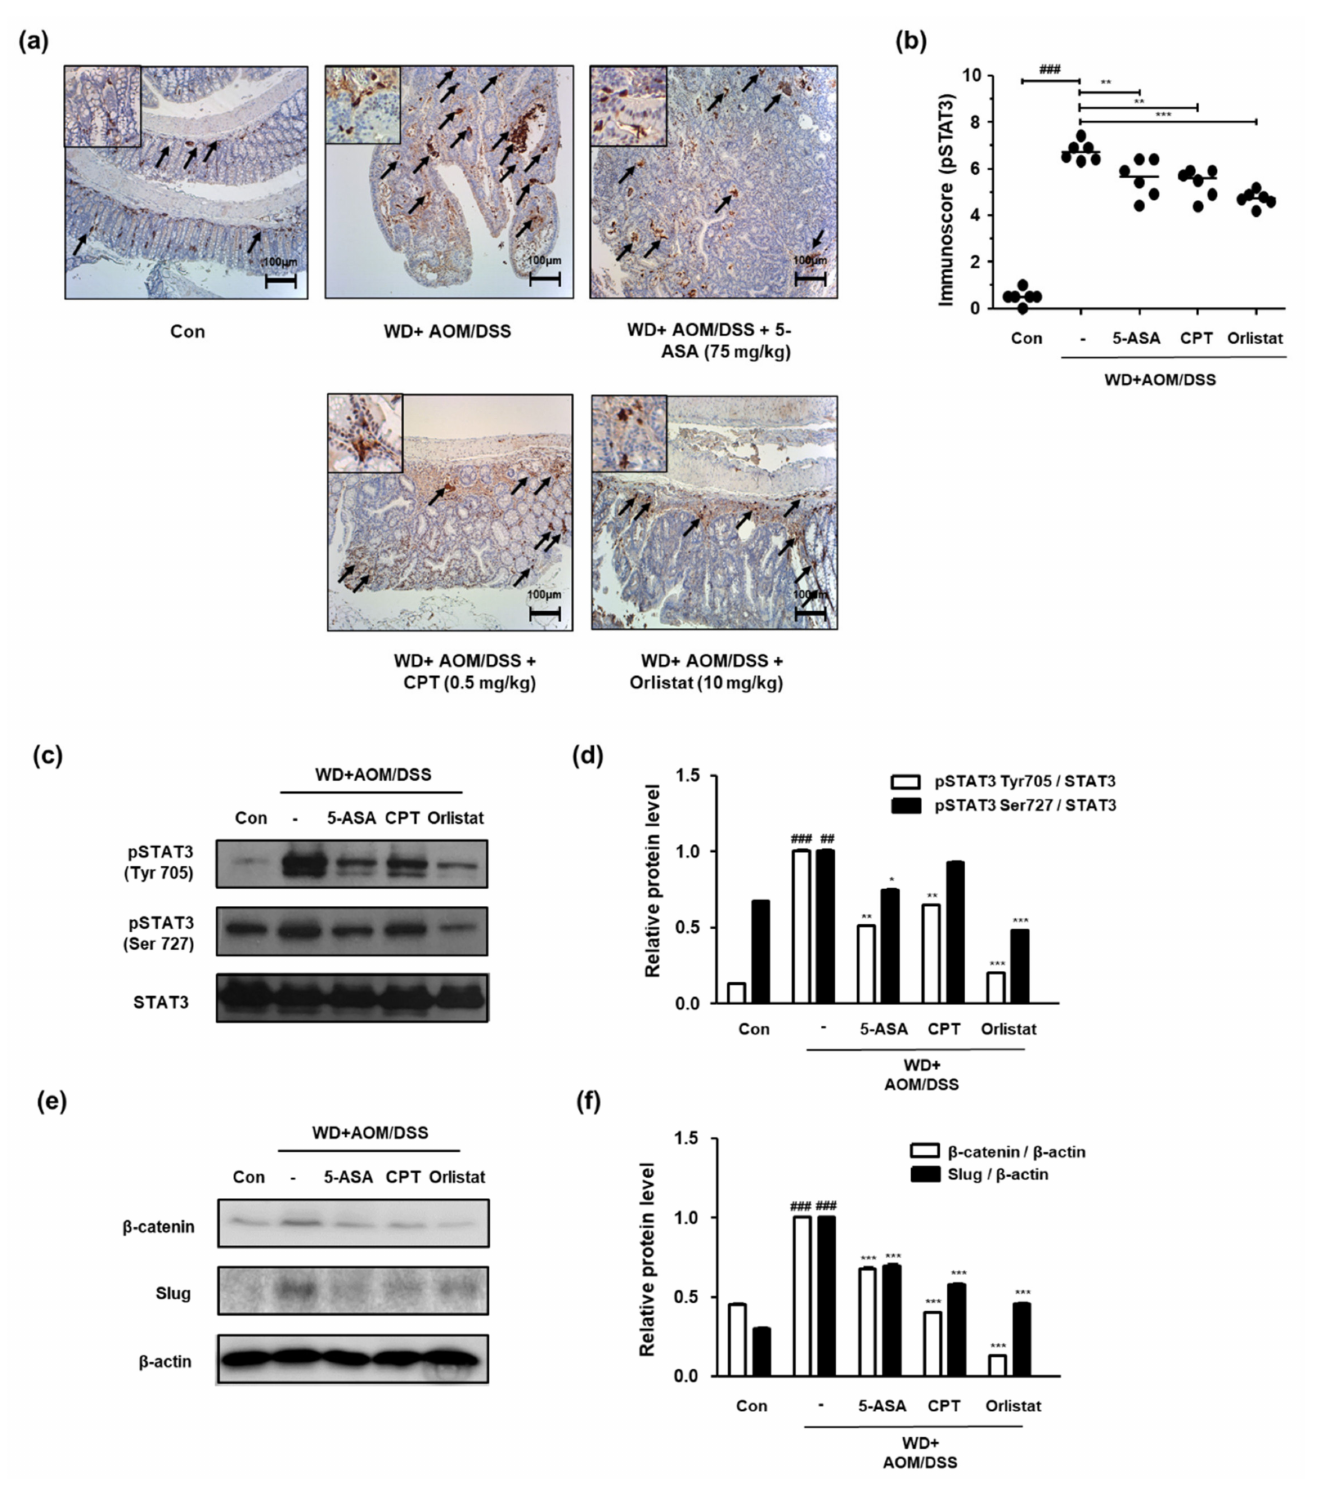
Figure 5. Effect of orlistat on the upregulation of STAT3 in WD-driven CAC mice. ( a ) Immunoreactivity of STAT3 Tyr705 was observed in colon tissues; ( b ) immunoscores for STAT3 Tyr705 in the colon of each group. Western blotting was conducted to detect the expressions of ( c ) pSTAT3 Tyr705 and Ser727; ( d ) relative protein levels for pSTAT3 Tyr705 and Ser727; ( e ) β -catenin and slug expressions; ( f ) β -catenin and slug relative protein levels. Relative protein levels calculated based on the internal control, STAT3, and β -actin. ## p < 0.01 and ### p < 0.001 when compared to Con; * p < 0.05, ** p < 0.01, *** p < 0.001 when compared to WD +